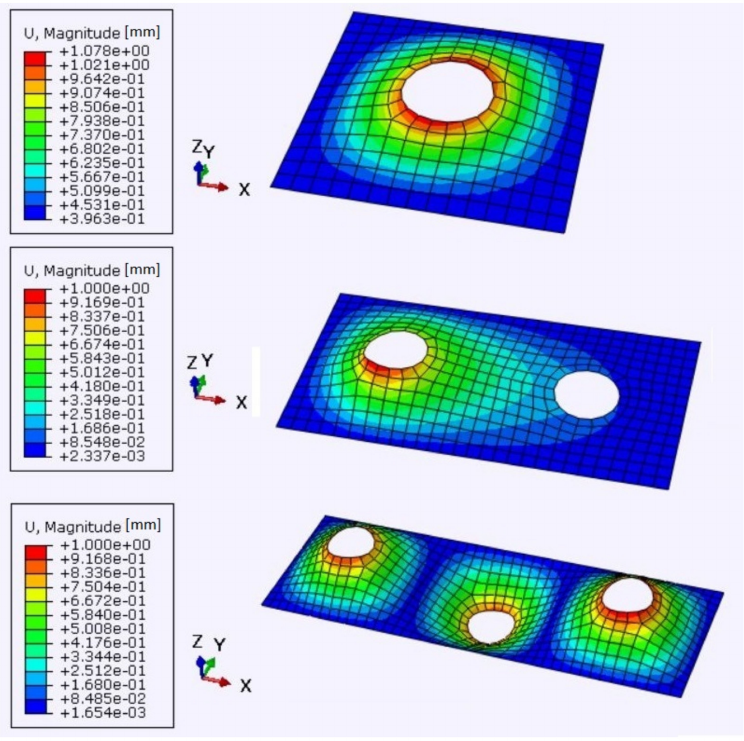
Figure 6. First buckling modes of plates with circular cut-outs and their normalized displacement fields.